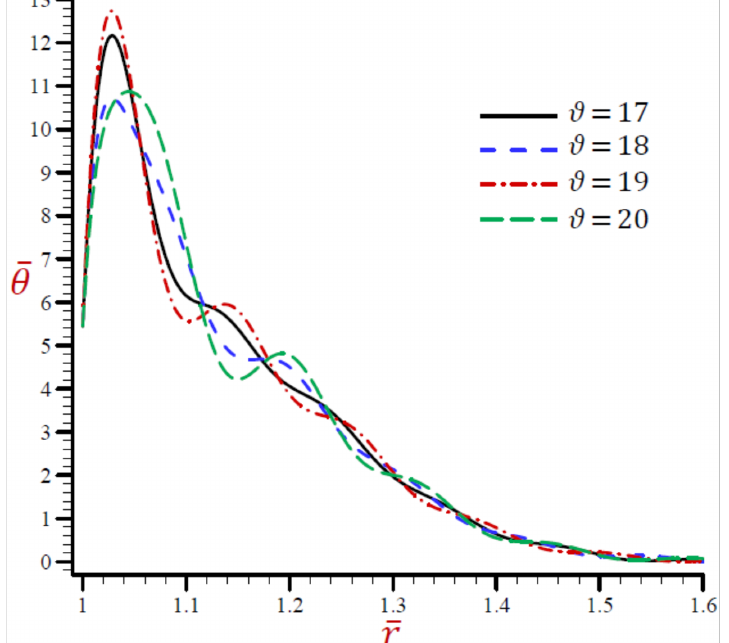
Figure 13. Effect of ϑ on temperature θ across the radial direction of the cylindrical cavity utilizing the RDPL